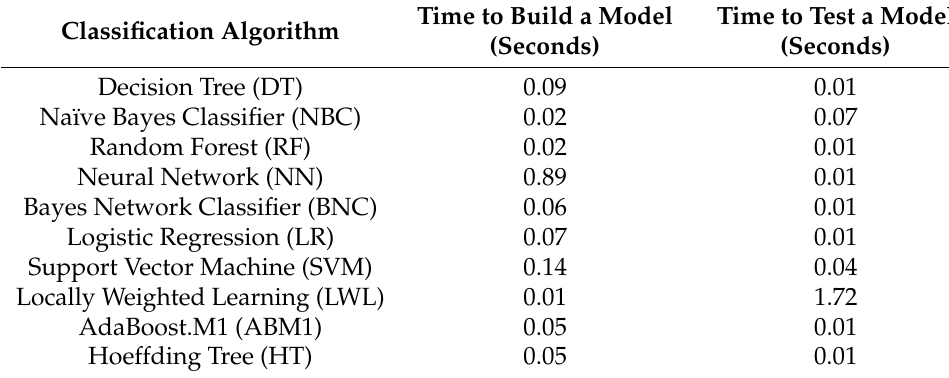
Table 5. Time performance of each algorithm. Classification